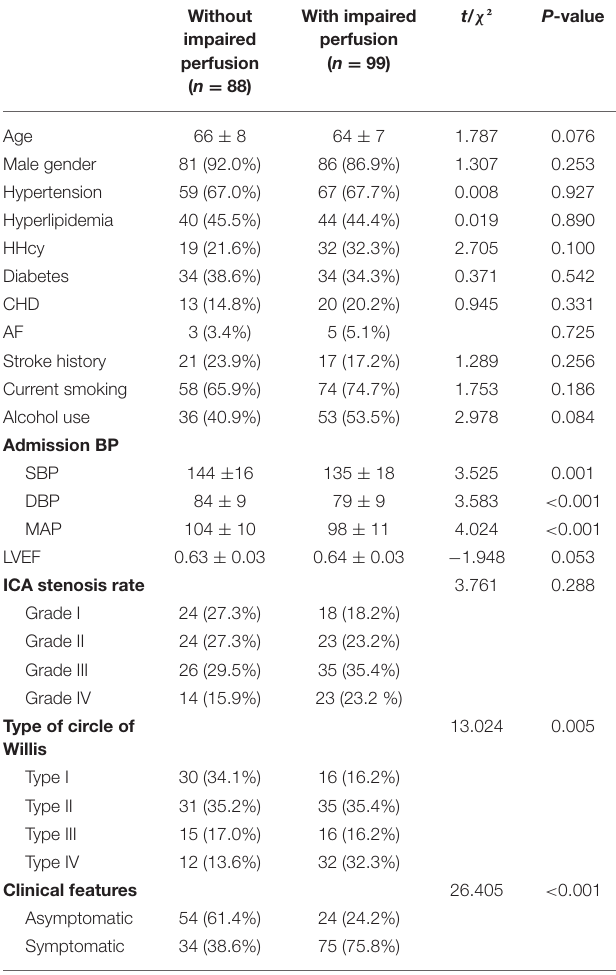
TABLE 1 | Univariate analysis of factors associated with impaired perfusion. TABLE 2 | Logistic regression analysis of factors associated with impaired